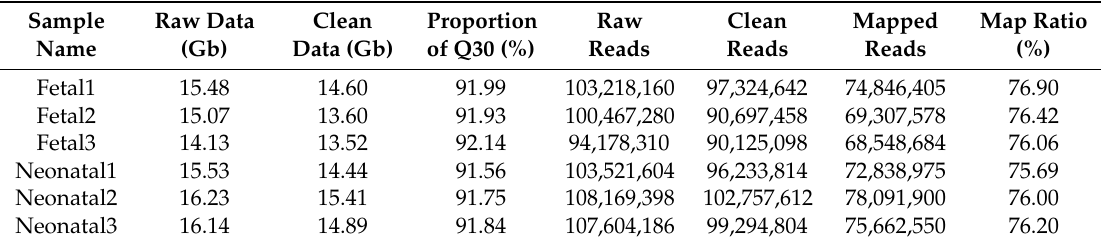
Table 1. Summary of data